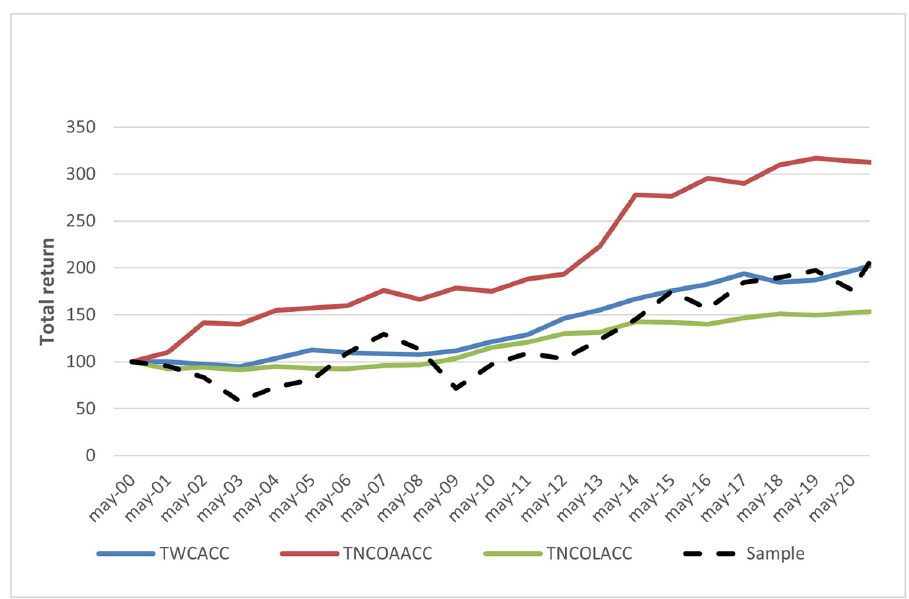
Fig 6. Comparative total